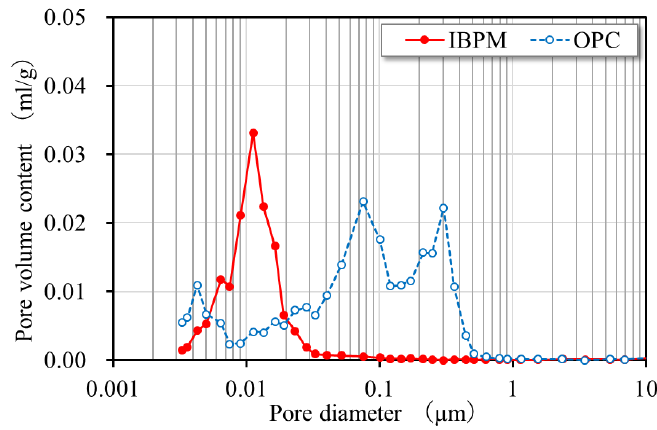
Figure 7. Pore size distributions at 91 days.